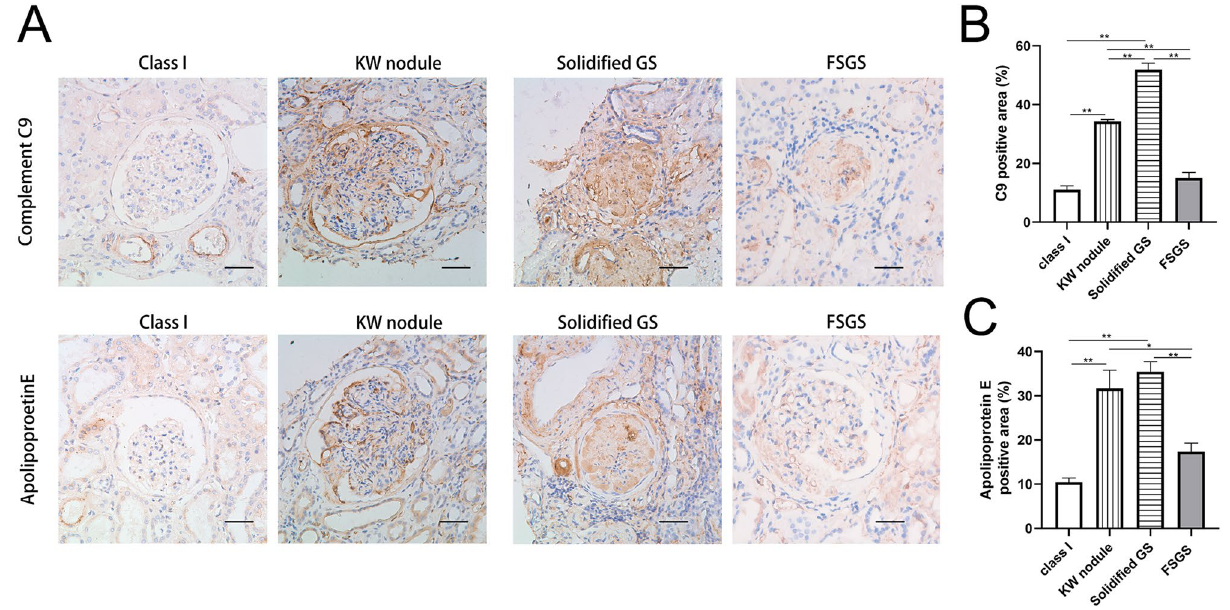
Figure 3. Distribution of complement C9 and apolipoprotein E in class I glomeruli in diabetic nephropathy, Kimmelstiel–Wilson (KW) nodules, solidified glomerulosclerosis (GS) and focal segmental glomerular sclerosis (FSGS). ( A ) Immunohistochemical staining for complement C9 and apolipoprotein E. ( B ) Quantification of complement C9 staining shows significant higher levels in KW nodules and solidified glomerulosclerosis (GS) than in class I glomeruli from a diabetic kidney or FSGS. ( C ) Quantification of apolipoprotein E staining shows significant higher levels in KW nodules and solidified GS than in class I glomeruli from a diabetic kidney or FSGS. Experiments were performed with samples from 10 participants for KW nodules, 10 for solidified GS, three for class I, and three for FSGS. Data are presented as mean ± SEM. * P < 0.05; ** P < 0.01. Bar = 50